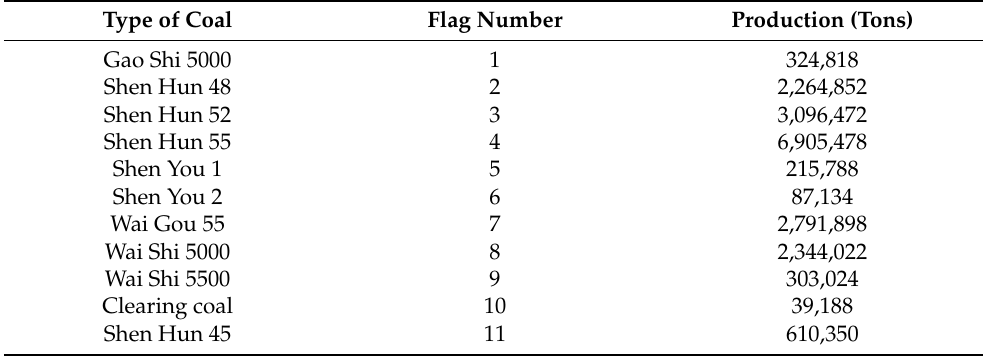
Table 1. Statistics of coal output of the port within 3 months.